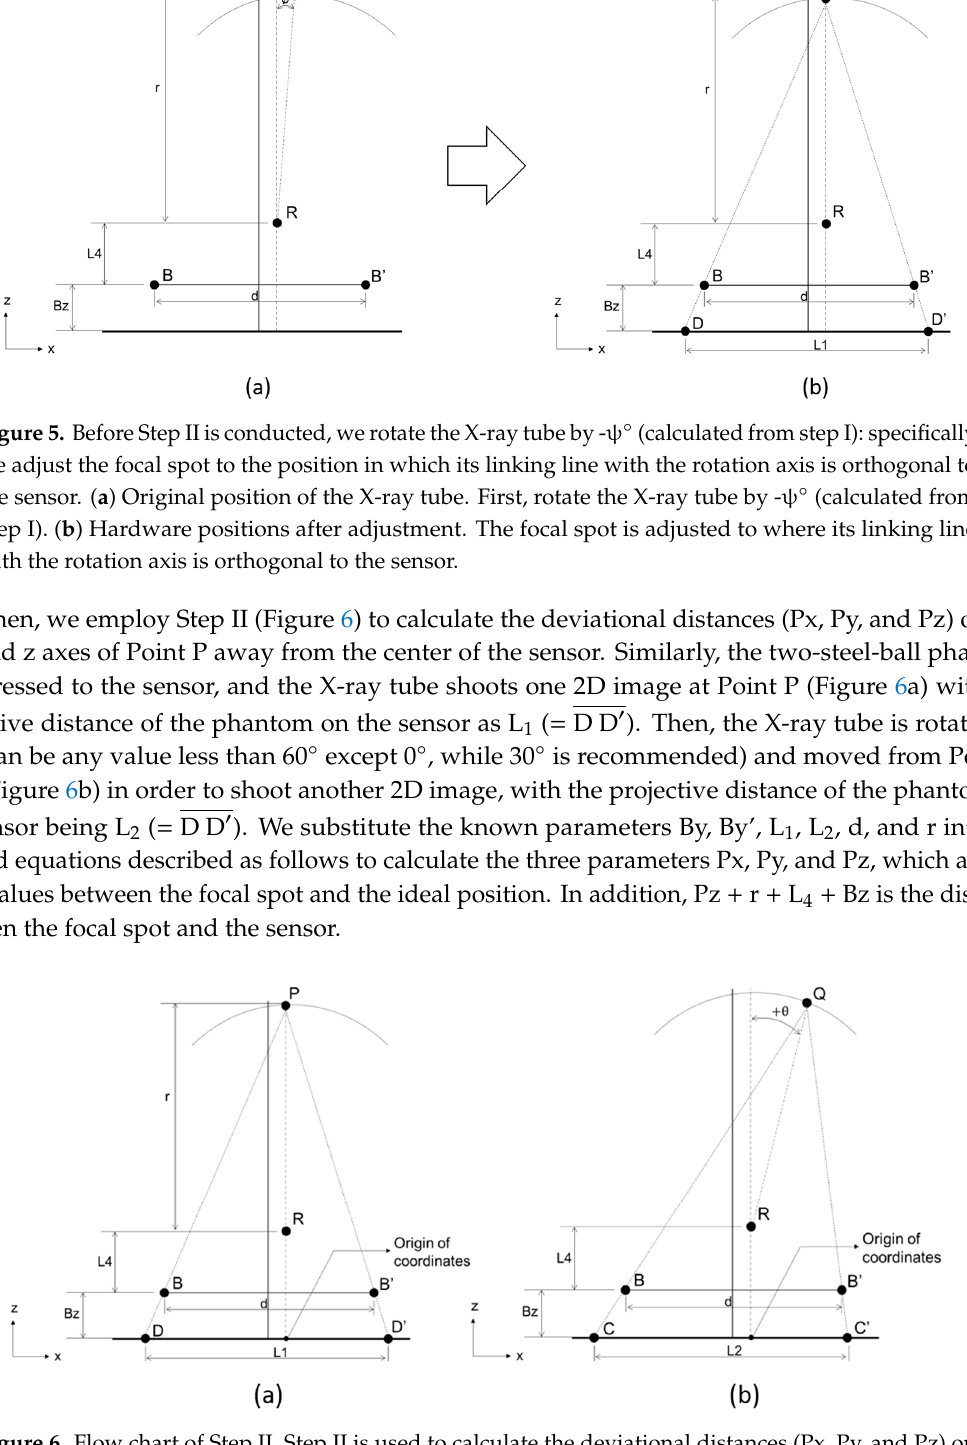
Figure 6. Flow chart of Step II. Step II is used to calculate the deviational distances (Px, Py, and Pz) on the x, y, and z axes of Point P away from the center of the sensor. First the X-ray tube is at Point P to shoot a 2D image, then moved from Point P to Q in order to shoot another 2D image. ( a ) Point P after the calibration in Step I. ( b ) Focal point rotates + θ °.